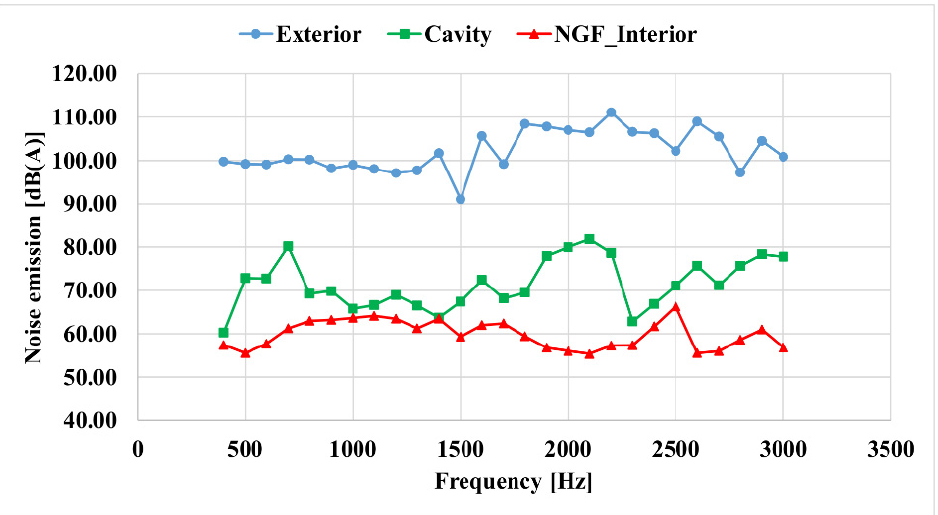
Figure 5. Noise level measured in exterior, in the cavity of the box double-skin façade and in a room with normal window, frequency interval 400–3000 Hz.